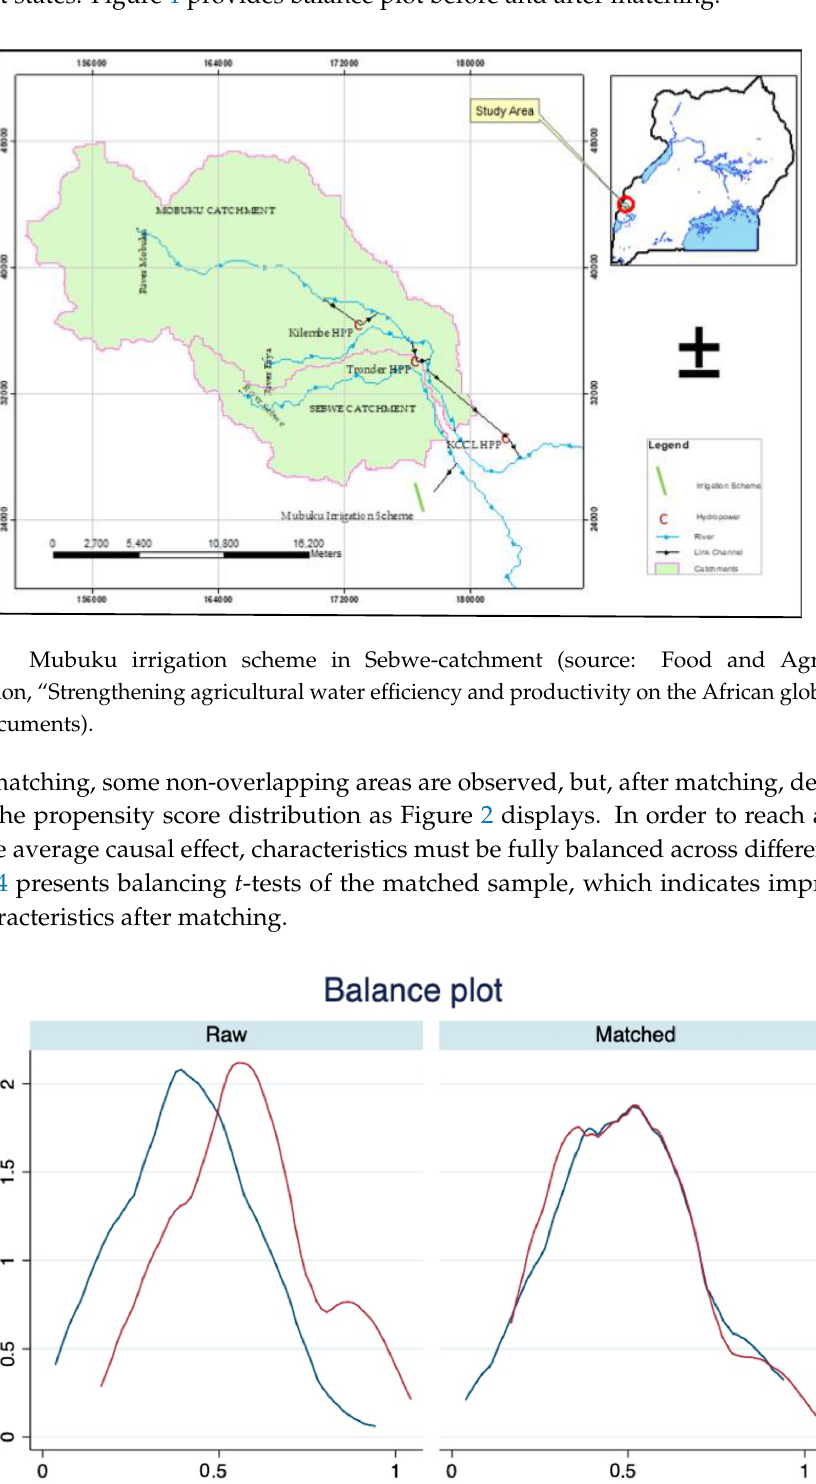
Figure 2. Balance plot of the propensity score before and after matching (created by psmtest, tbalance density command in STATA).